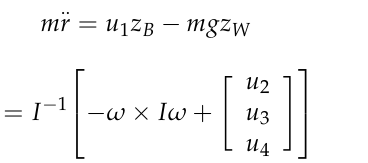
Figure 4. Schematic diagram of the relationship between the inertial coordinate system and body coordinate system.